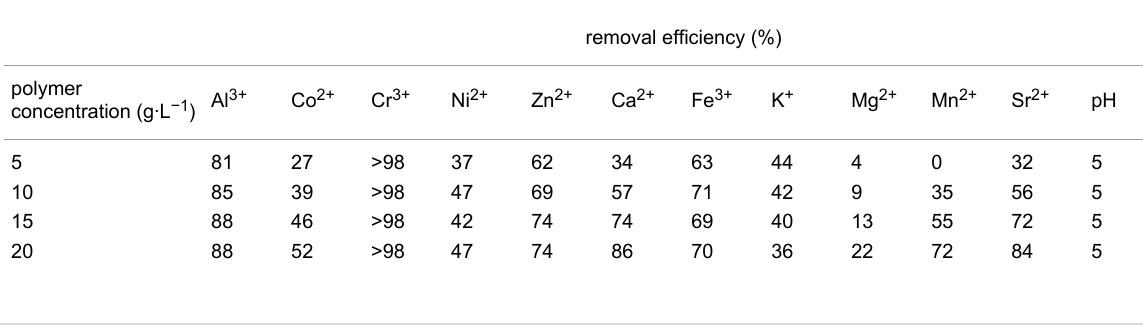
Table 4: Removal efficiency of inorganic elements (%) in DW according to polymer concentration.